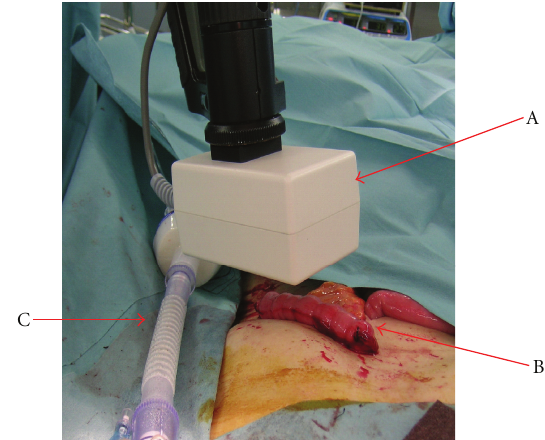
Figure 4: Laser flowgraphy in a case involving a musculocutaneous (MC) flap for treating a patient with tongue